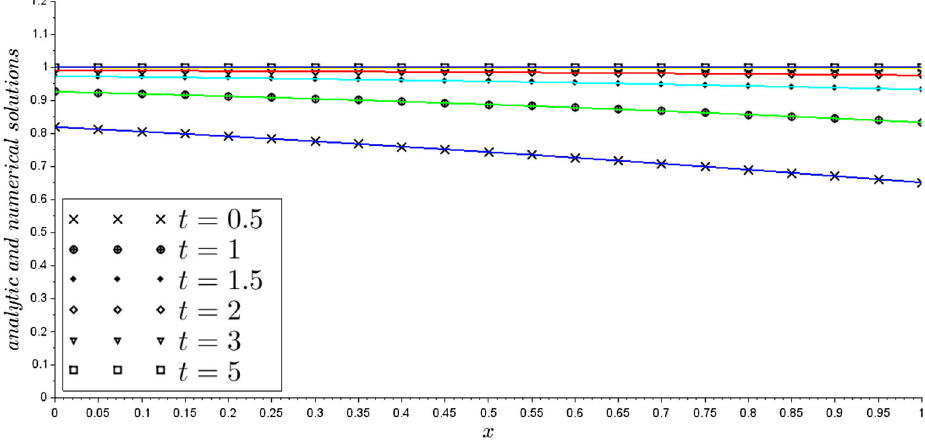
Fig. 1 I-EFD solution of Example 5.1 for (cid:2) t = 0 . 001 and (cid:2) x = 0 .